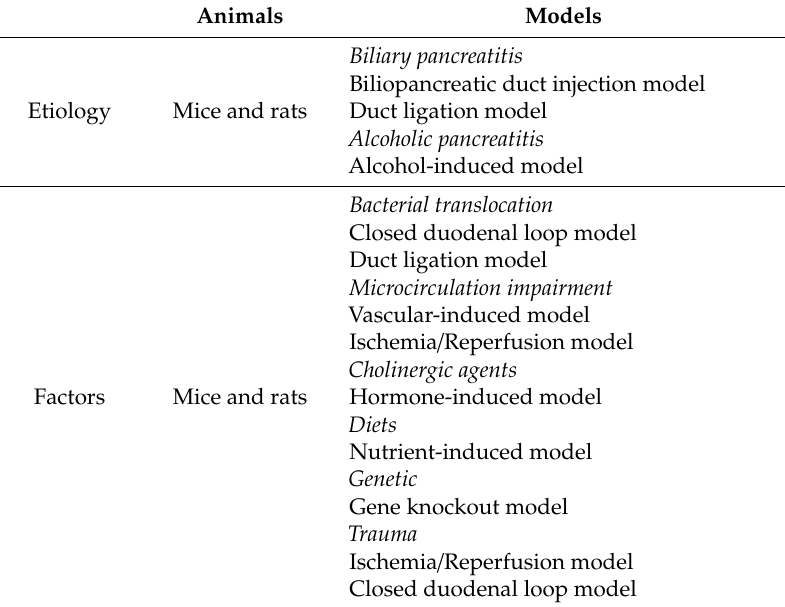
Table 2. Animal models for acute pancreatitis according to the etiology and